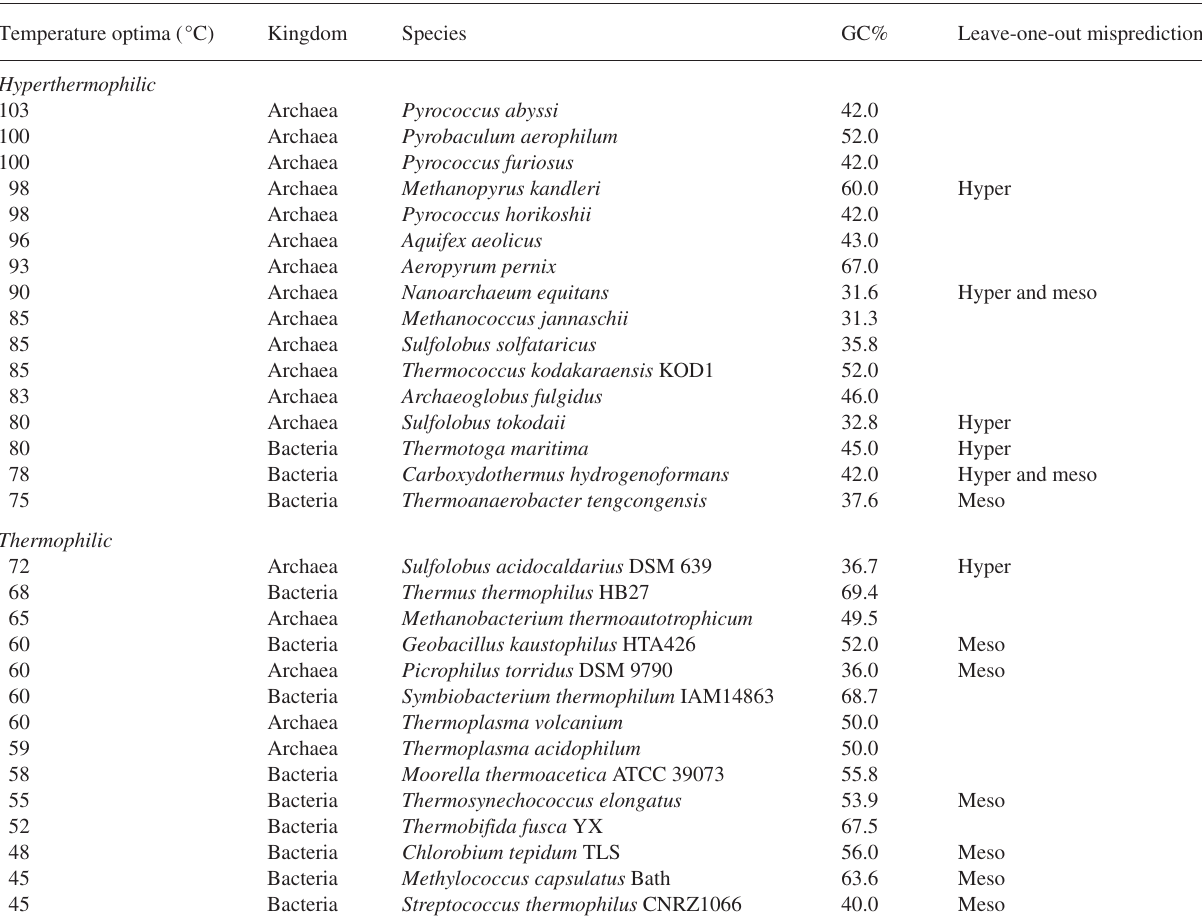
Table 1. The NCBI-reported temperature optima and GC% of 16 hyperthermophilic (12 archaea and 4 bacteria) and 14 thermophilic (5 archaea and 9 bacteria) species. An additional 165 mesophilic (7 archaea, 158 bacteria) species were also included in our analysis (data not shown). Leave-one-out mispredictions shows the type of misprediction when classifying the temperature optimum of an organism (hyperthermphile ver- sus non-hyperthermophile (hyper) or mesophile versus non-mesophile (meso)) based on a model from the genomes of the other 194 organisms, using tetramer frequencies as the sole